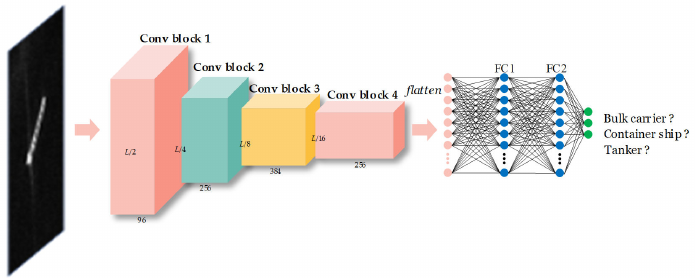
Figure 6. Network architecture of AlexNet.